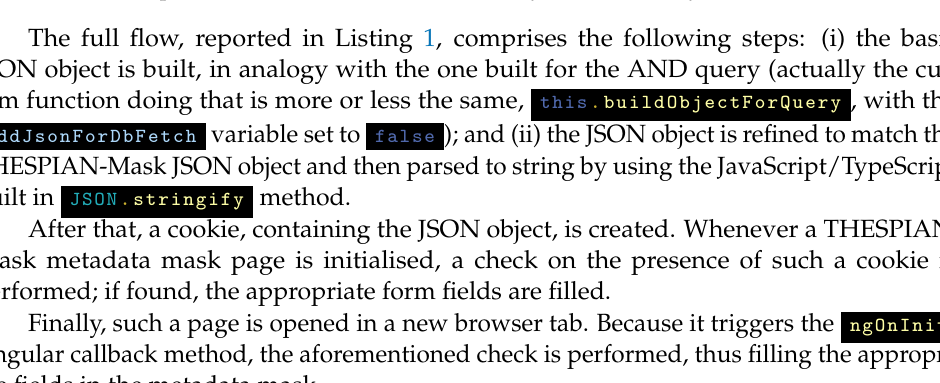
Figure 9. Visual explanation of the flow from label/entity selection to key/value metadata